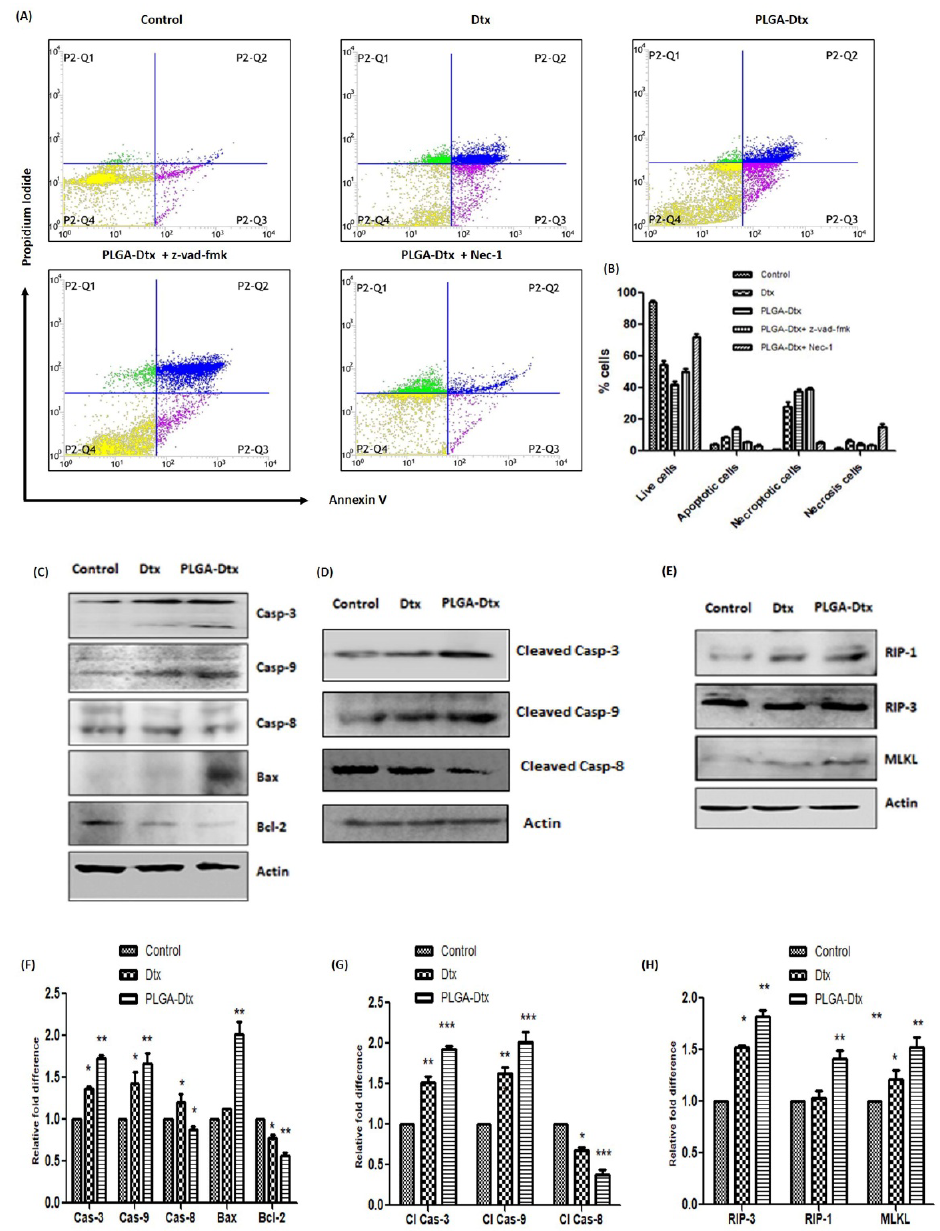
Figure 3. Flow cytometry analysis of lung cancer cell death mode caused by Dtx/PLGA-Dtx. ( A ) Influences of Z-VAD-fmk and Nec-1 on apoptotic and necroptotic cells, respectively. A549 cells were pretreated with 20 µ M Z-VAD-fmk or 50 µ M Nec-1 for 30min and subsequently treated with IC 50 value of PLGA-Dtx and relative dose of Dtx for 24h; ( B ) representative bar diagram to show the percentage of cell death including live cells, apoptotic cells, late apoptosis/necroptosis, and necrosis; influences of Dtx and PLGA-Dtx on apoptotic and necroptotic signaling proteins. A549 cells were treated with IC 50 value of PLGA-Dtx and relative dose of Dtx for 24h and cell lysates were analyzed by western blot with indicated antibodies. ( C ) apoptotic proteins; ( D ) cleaved caspases; ( E ) necroptotic proteins; ( F – H ) representative bar diagram showing fold difference in apoptotic and necroptotic protein levels. Data were the mean ± SEM from at least three independent experiments. (* p < 0.05, ** p < 0.01, and *** p < 0.001 compared with the control group.) Consistently, PLGA-Dtx upregulated late apoptosis/necroptosis (36 ± 3.4%) as com- pared with the control (1.2 ± 0.04%). However, as suggested by the cell toxicity data, the effect of Dtx was less pronounced in A549 cells. The apoptotic and necroptotic cell